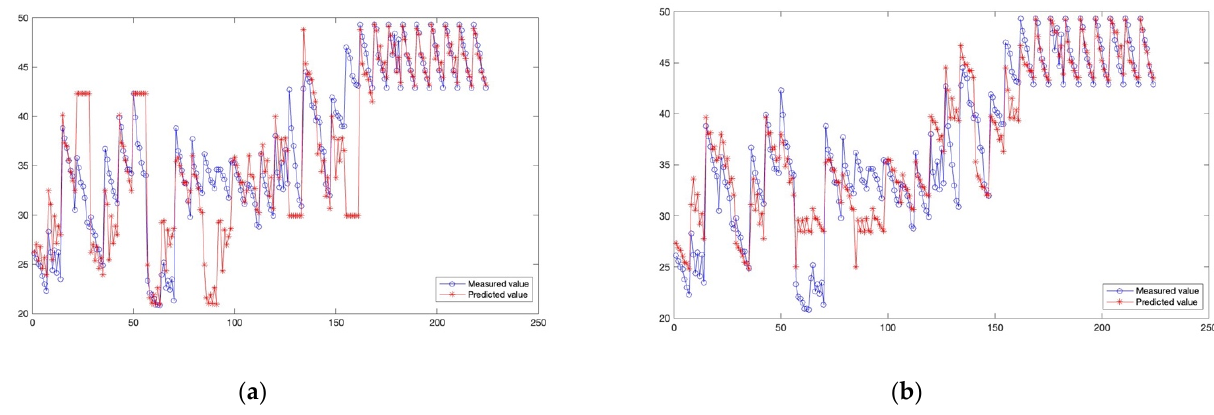
Figure 13. The comparison between the actual value of the surface roughness (Rmax) and the predicted value of the BP ( a ) and the CPA-BP ( b ) model is shown in Figure 13. As can be seen in Figure 14, the error curve of CPA-BP for the prediction of surface roughness is much flatter than that of the BP model. The smaller error proves that the CPA-BP model has a great optimization effect. It can also further prove that the prediction accuracy of CPA-BP is more accurate.